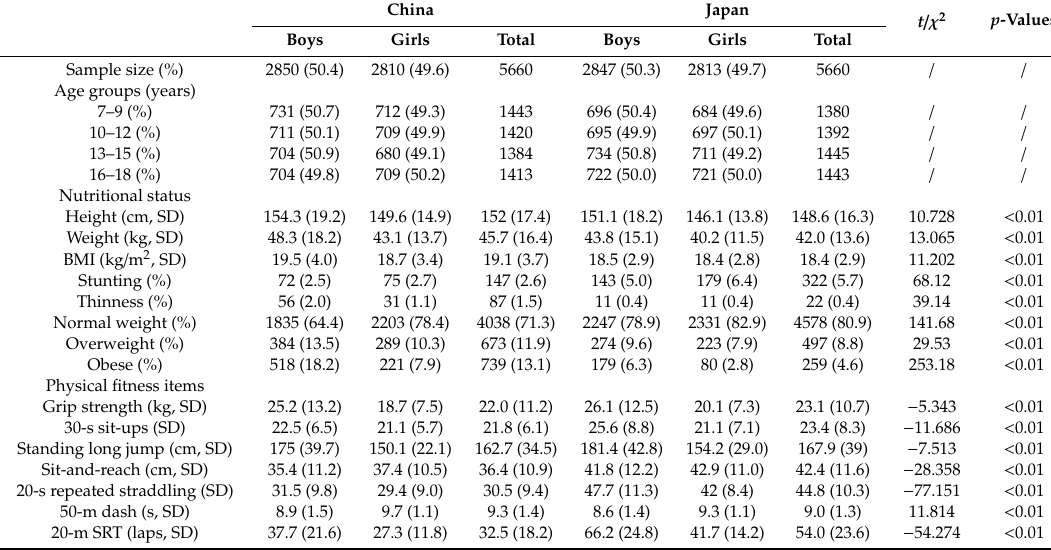
Table 1. Basic characteristics, nutritional status, and physical fitness status among Chinese and Japanese children and adolescents aged 7–18 years. China